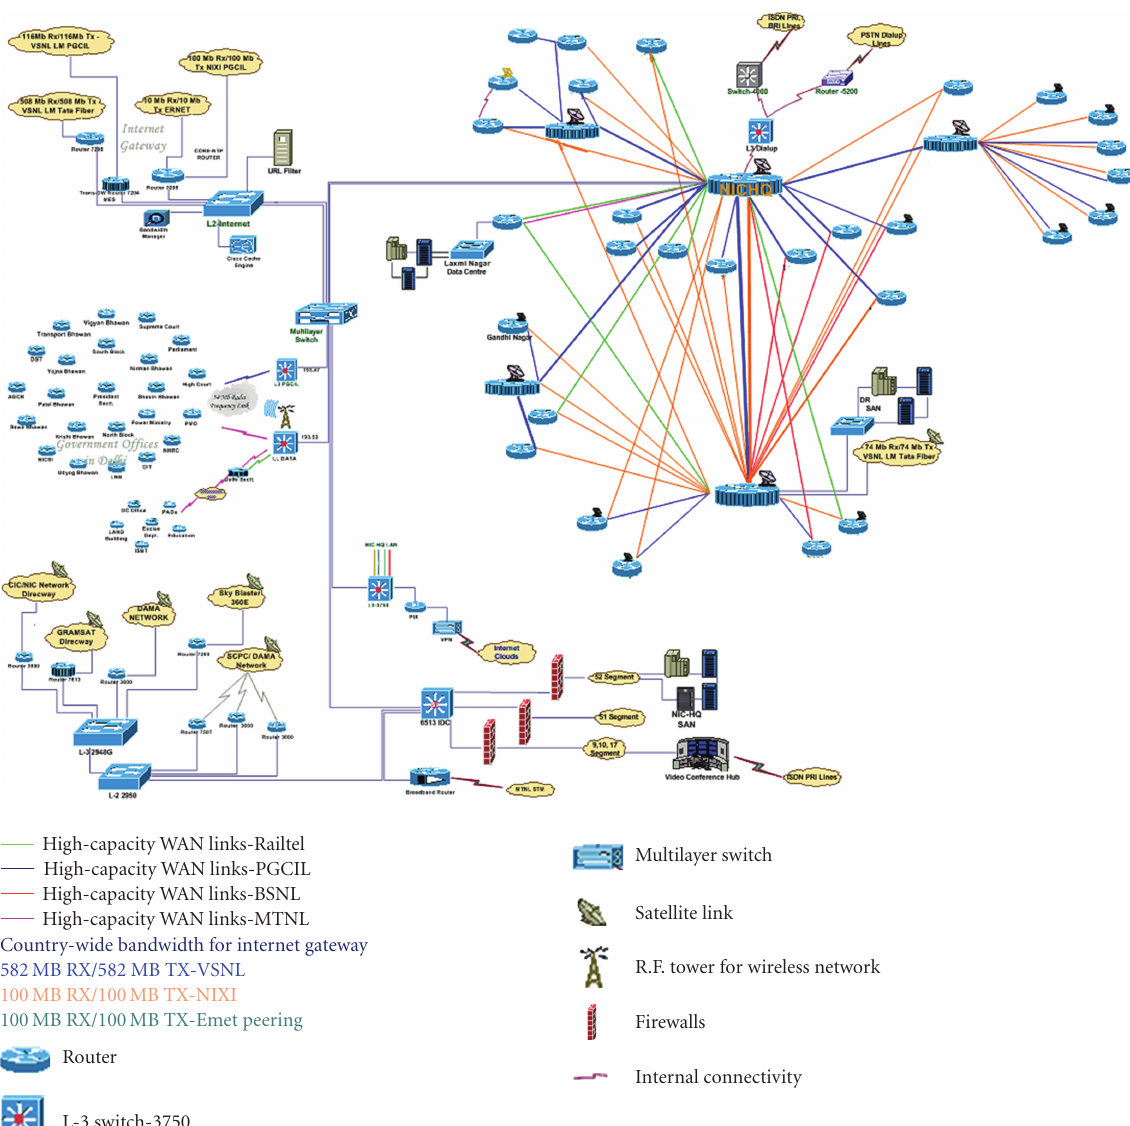
Figure 1: Typical network